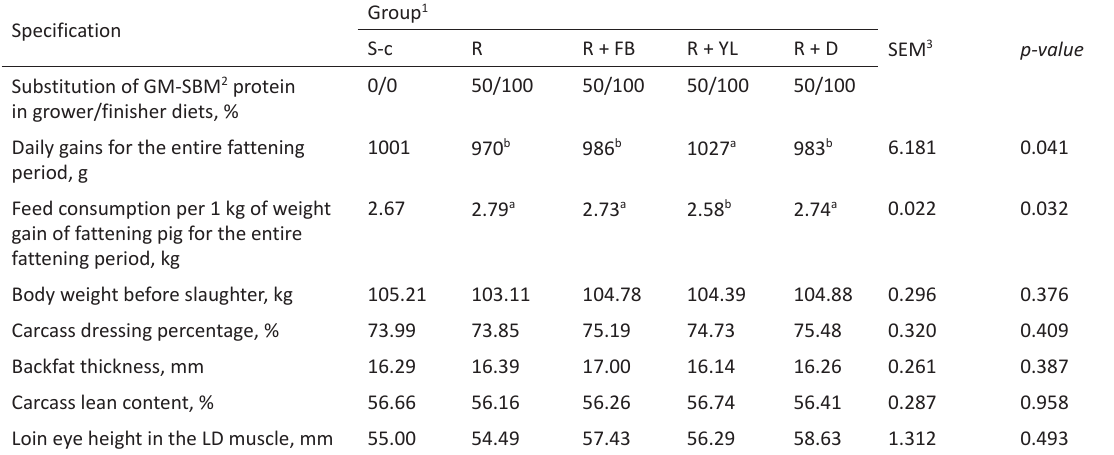
Table 3. Fattening effects, live weight of growing-finishing pigs and carcass quality (